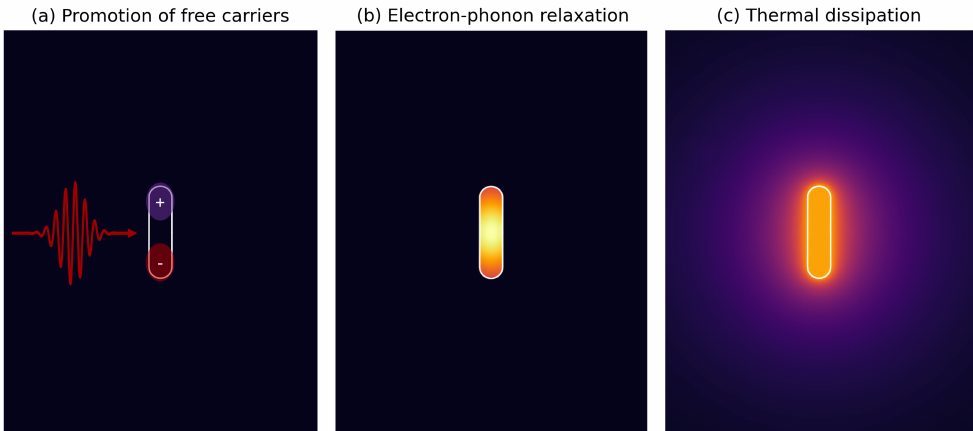
Figure 1. Illustration of photothermal phenomena dynamics of metallic NPs, from ( a ) promotion of free carriers (fs) and ( b ) electron − phonon relaxation (ps), to ( c ) heat exchange with the surrounding medium (ps to